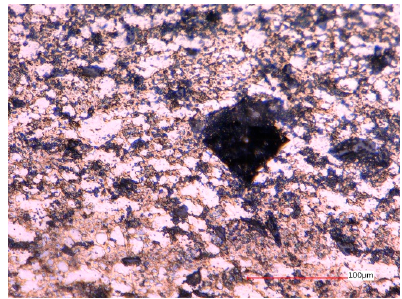
Figure 2. Light microscope image of indentation in as-sprayed 33% Al coating.